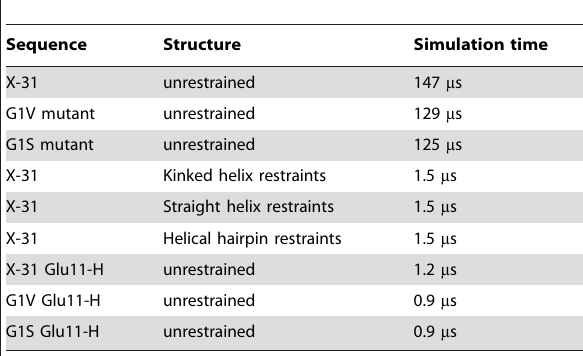
Table 1. Summary of simulations